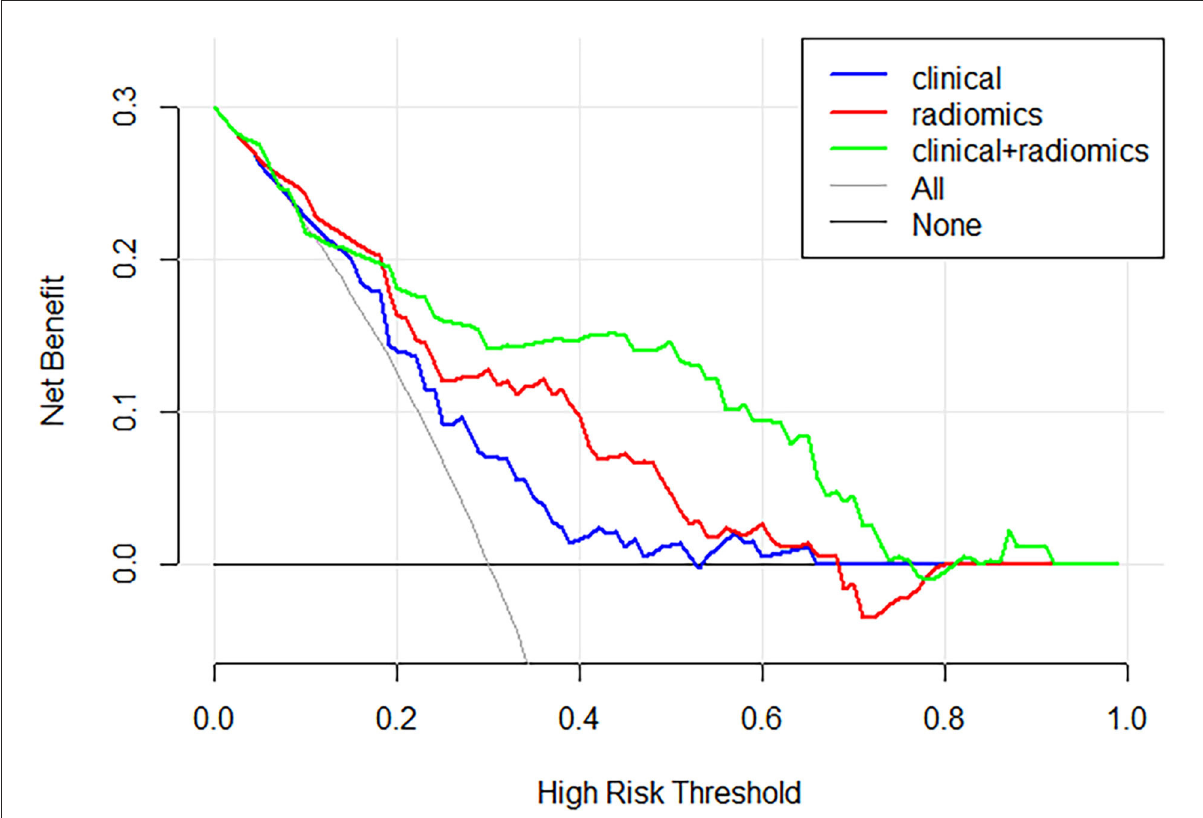
FIGURE5 Decision curve analysis for each model. The combination model had the highest net benefit compared with both the other